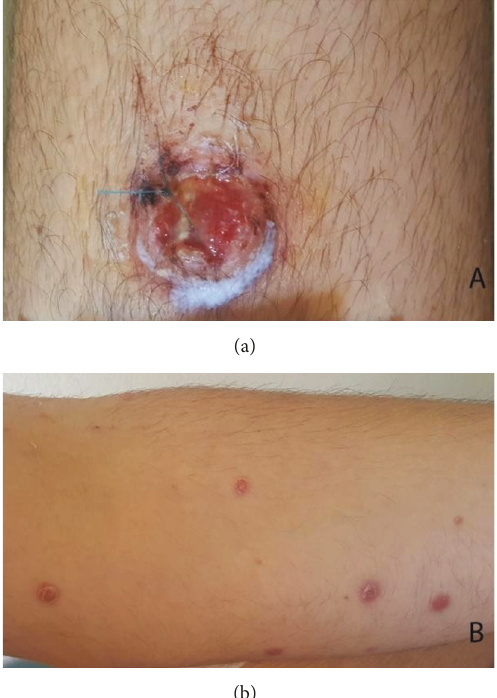
Figure 1: A large ulcerated 3 × 3 cm tumor on the extensor surface of the left thigh at presentation (a); a widespread erythematous papulonodular eruption involving the face, the trunk and the extremities with occasional scaling at the periphery of the lesions